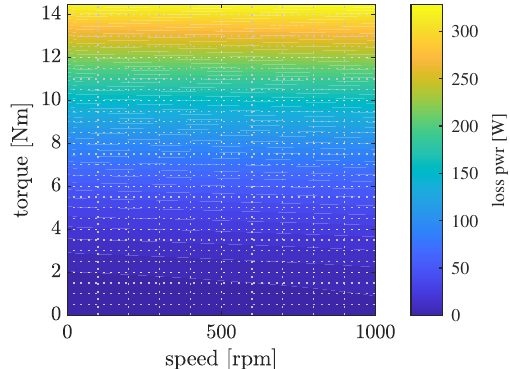
Figure 11. PMSM total power loss in torque-speed